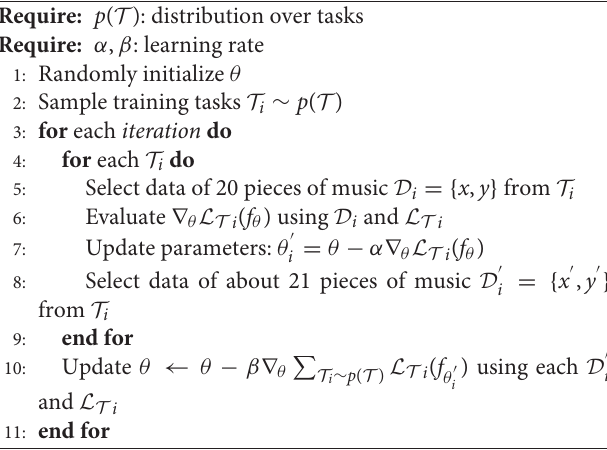
Algorithm 1 : MAML for emotion prediction using EEG